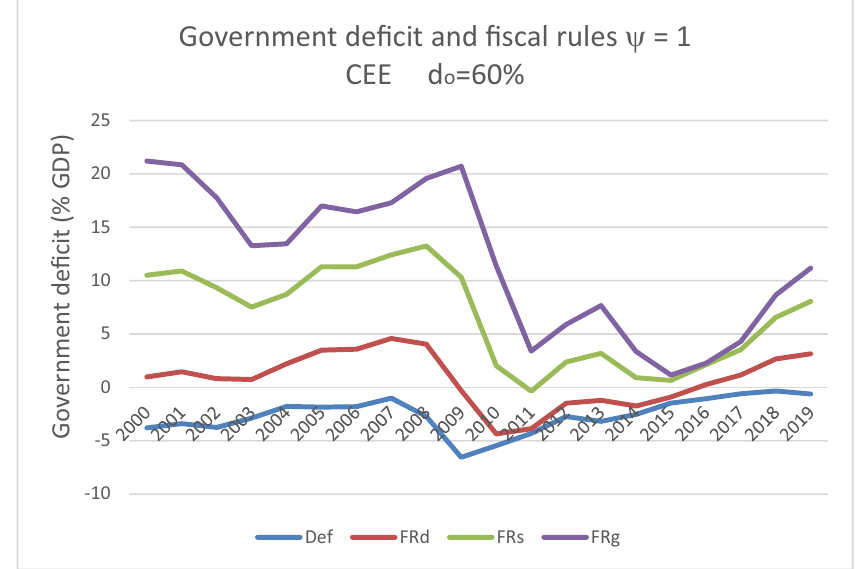
Figure 1.5: CEE countries government de fi cit ψ = 1 ( Source: Own elaboration from data on Table 1 ) .